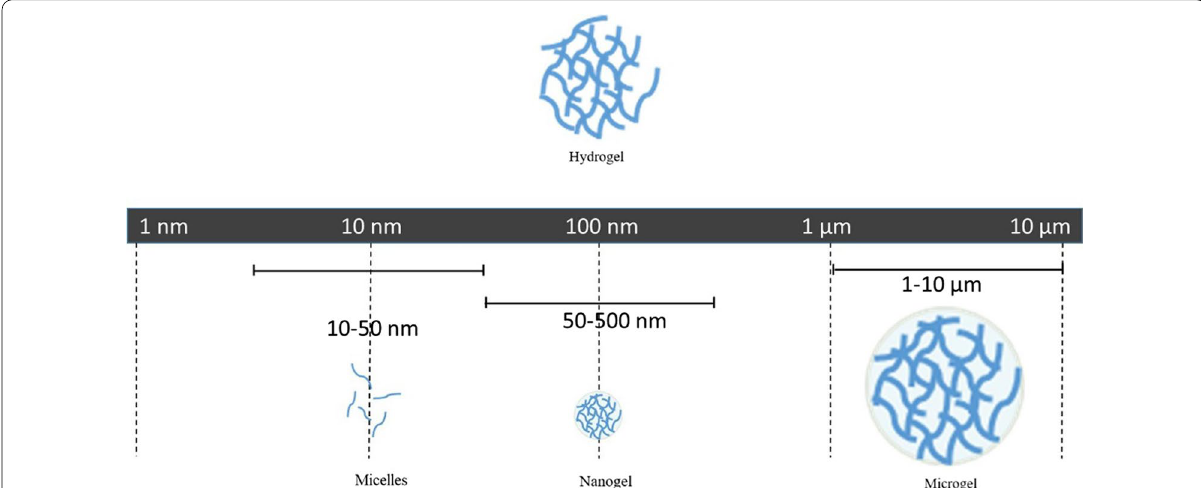
Fig. 8 Schematic representation of the network construction of hydrogels, micelles, nanogels and microgels. Referred from [175] with